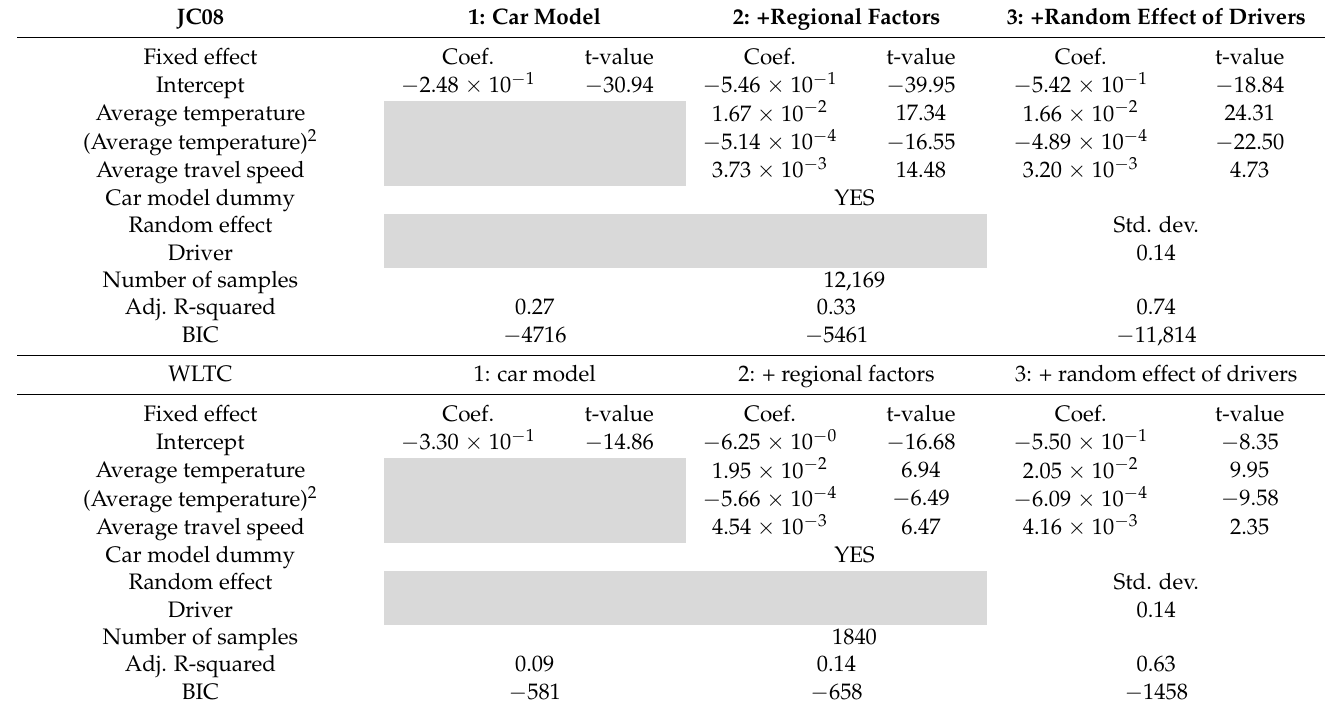
Table 3. Estimation results of deviation between actual and the JC08 (top) and the WLTC (bottom) mode fuel economy.